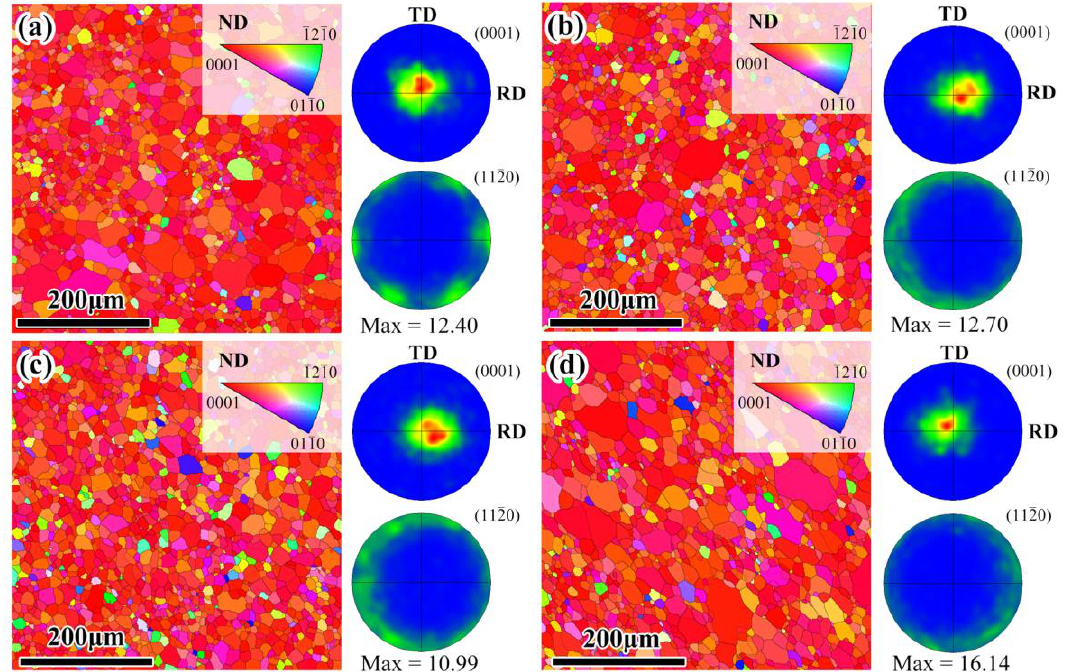
Figure 7. Inverse pole figure and pole figure of the Mg layers in composite sheets after annealing: Mg/Al sheet after annealing at ( a ) 400 ◦ C for 3 h, and ( b ) 400 ◦ C for 10 h, Mg/Al-Ti sheet after annealing at ( c ) 400 ◦ C for 3 h, and ( d ) 400 ◦ C for 10 h. RD, TD, and ND refer to the rolling direction, transverse direction, and normal direction,